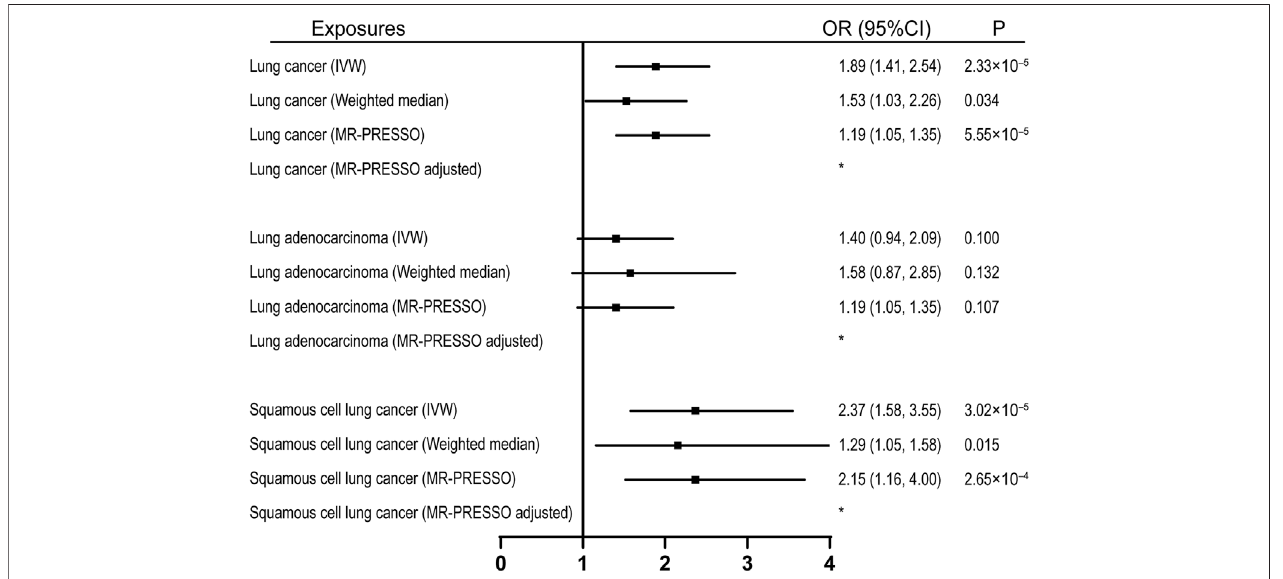
FIGURE 1 | Univariable MR analyses showing the causal effects of genetically proxied leisure television watching on overall lung cancer and different histological types with IVW, weighted median, and MR-PRESSO methods. *No outlier detected. IVW, inverse-variance weighted; OR, odds ratio; CI, con fi dence interval; MR, Mendelian